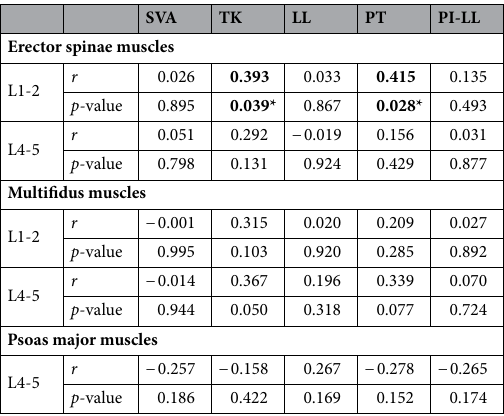
Table 1. Relationship between the fat infiltration rate in lumbar paravertebral muscles and static radiological spino-pelvic parameters. SVA sagittal vertical axis, TK thoracic kyphosis, LL lumbar lordosis, PT pelvic tilt, PI-LL pelvic incidence minus lumbar lordosis, r correlation coefficient. * p < 0.05. Significant correlation shown in bold.